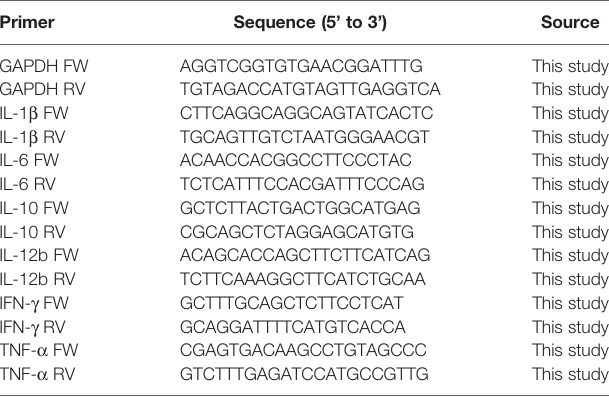
TABLE 2 | Primers used in quantitative real-time PCR analysis.